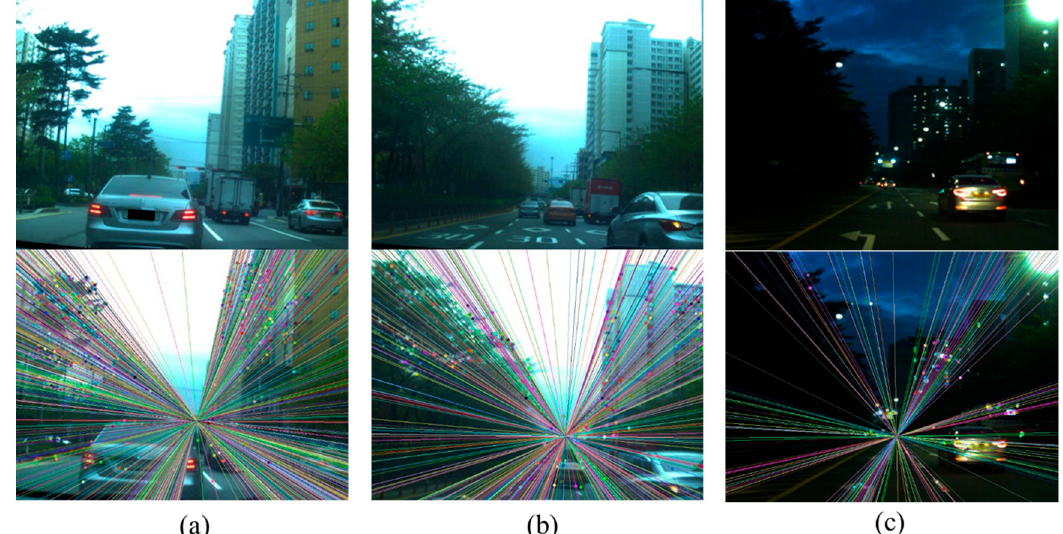
Figure 5. Epipolar line drawn (lower) on example images (upper). ( a ) Example image 1; ( b ) example image 2; ( c ) example image 3.